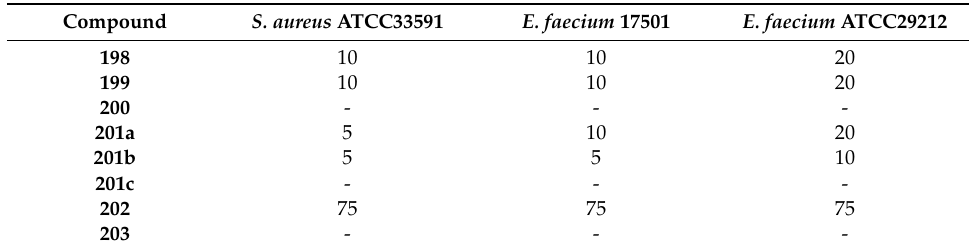
Table 29. Antibacterial activity of 198 – 203 against S. aureus ATCC33591 (resistant to methicillin), E. faecium 17501 (vancomycin-resistant clinical isolate), and E. faecium ATCC29212: activity is expressed as MIC values in µ M.